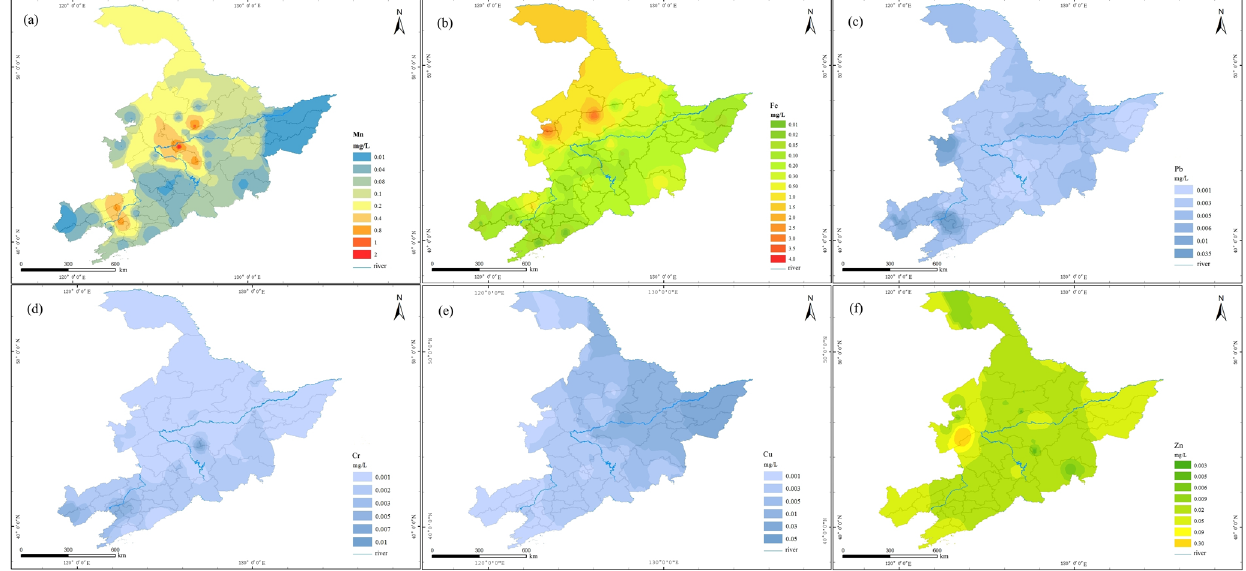
Figure 4. Prediction map of concentration distribution of heavy metals in drinking water sources in typical villages and towns in M area ( a ) Mn, ( b ) Fe, ( c ) Pb, ( d ) Cr 6+ , ( e ) Cu and ( f ) Zn.